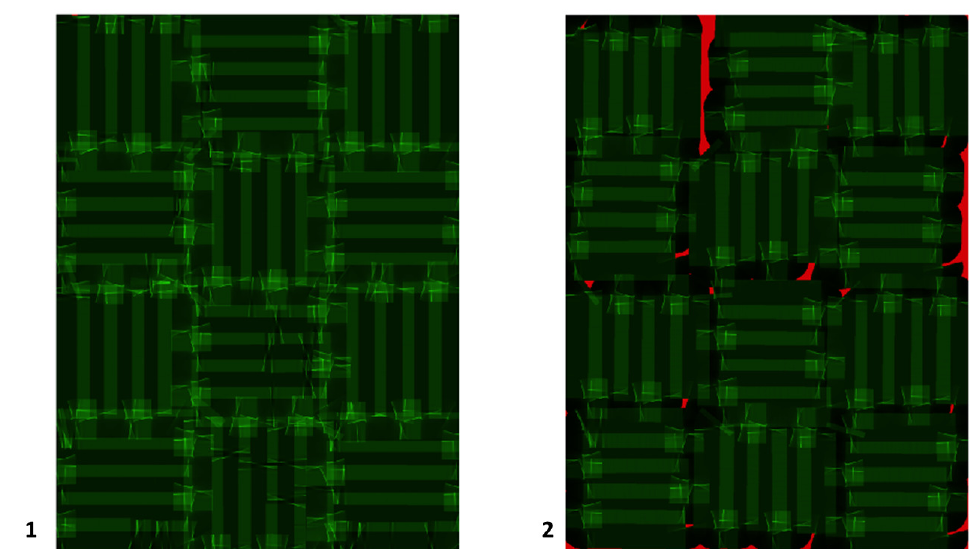
Figure 4. Area covered by a swarm of AUVs: left picture (number 1) is the coverage with communi- cation, and the right picture (number 2) without communication. Red color represents no coverage, and the green intensity indicates the amount of scans on the